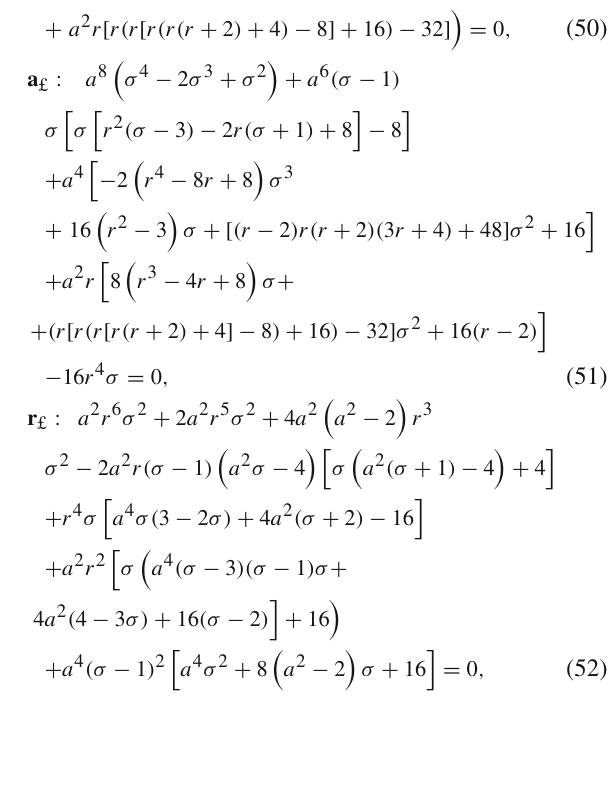
solutions ω ± =constant on the ( r / M ,σ) plane. Note the frequencies sign, always positive in the ergoregion (red curves are the ergosurfaces r ± (cid:9) ), horizons are also show. The curves are studied for different spins a / M > 0. See the analysis of Sect. 2 on the crossing of metric bundles and determination of orbital limiting